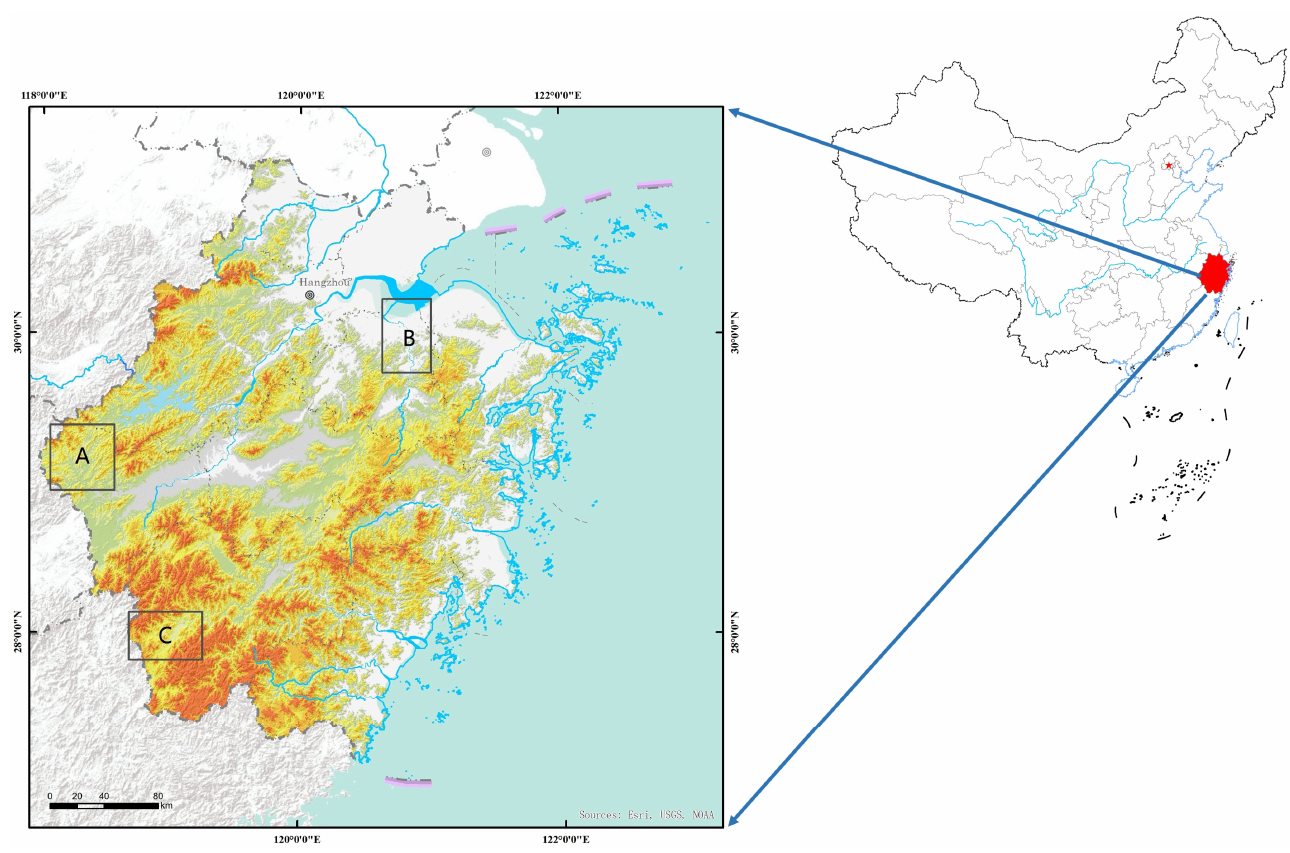
Figure 1. A map showing the study areas (A, B, and C means three different rice-growing areas where the sampling work was